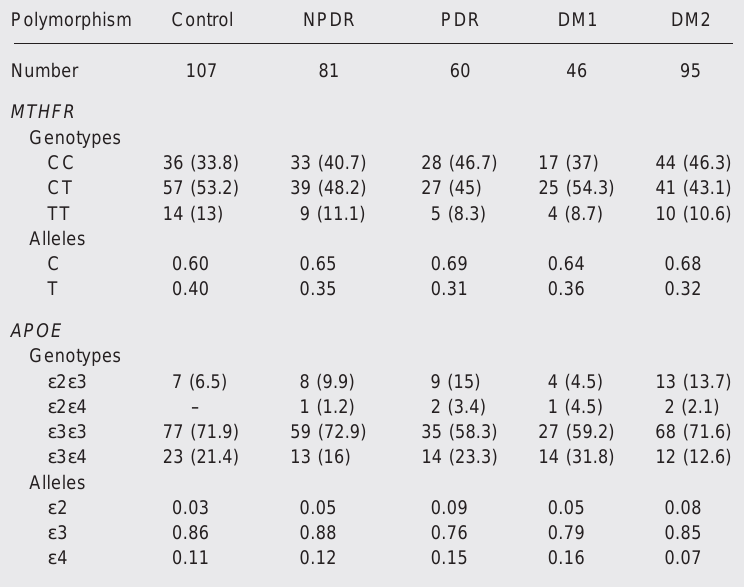
Table 2. Genotype and allele distribution of MTHFR and APOE polymorphisms in diabetic patients with retinopathy and controls.